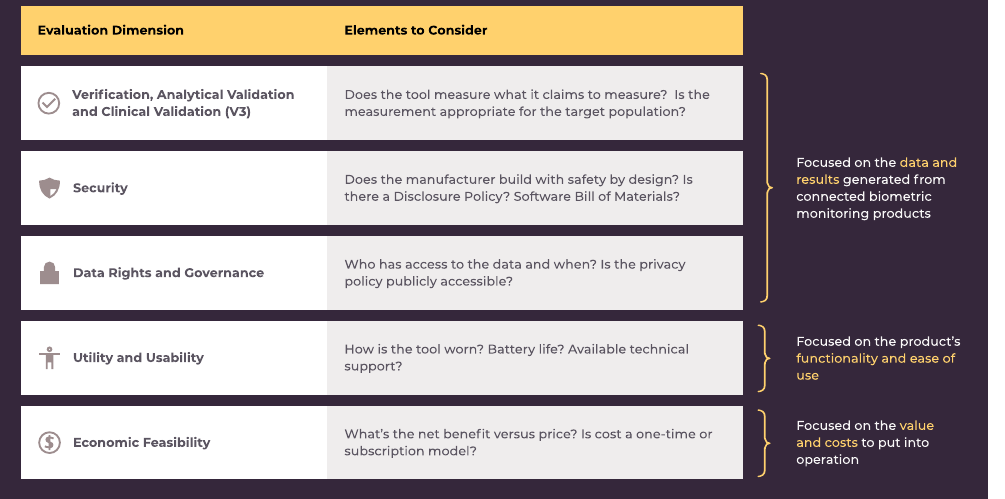
Fig. 2 Proposed Evaluation Framework for Fit-For-Purpose Connected Sensor Technologies. The proposed framework describes the key dimensions to be considered when evaluating connected sensor technologies. Dimensions can be grouped into broader categories of data and results; functionality and ease of use; and value and